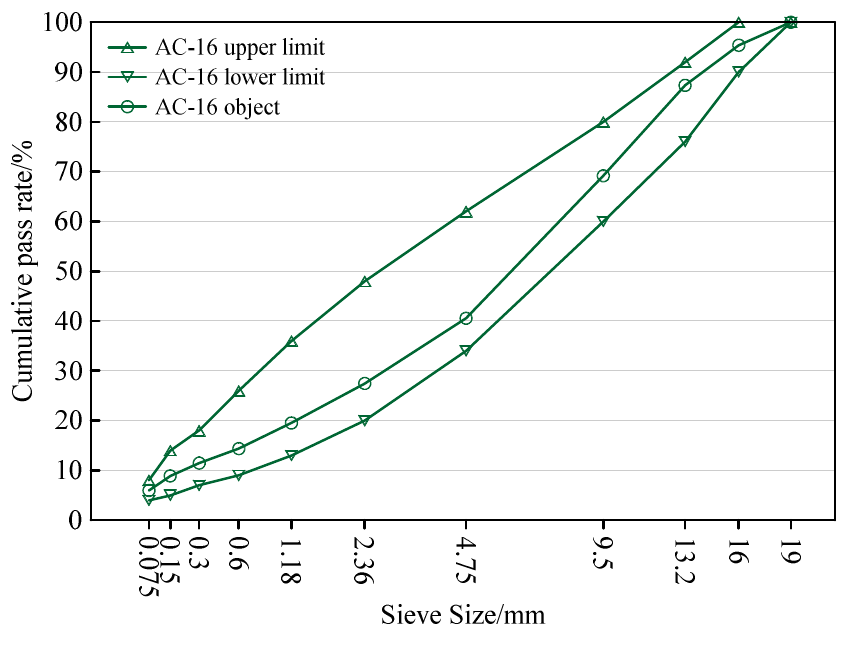
Figure 2. AC-16 grading curve for construction.